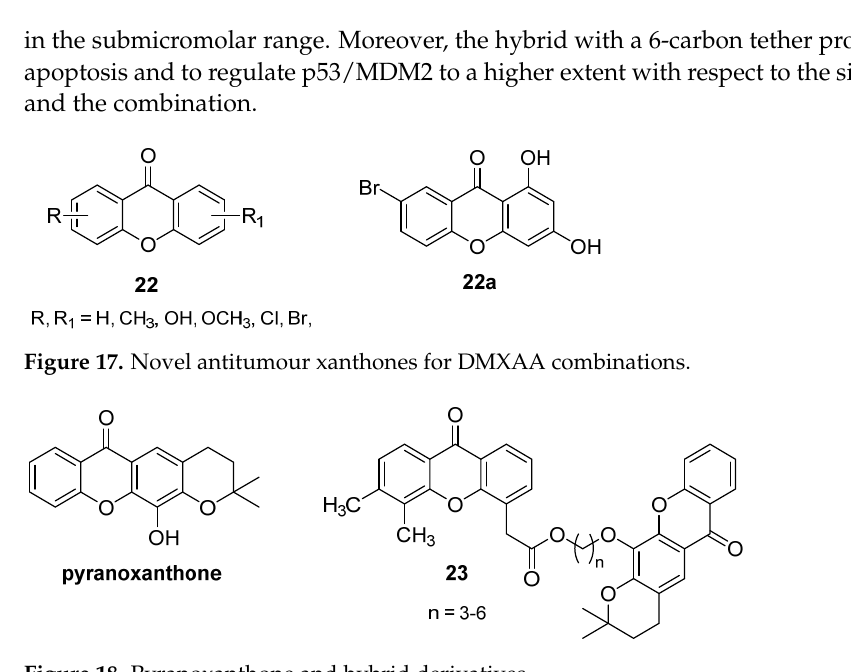
Figure 17. Novel antitumour xanthones for DMXAA combinations.